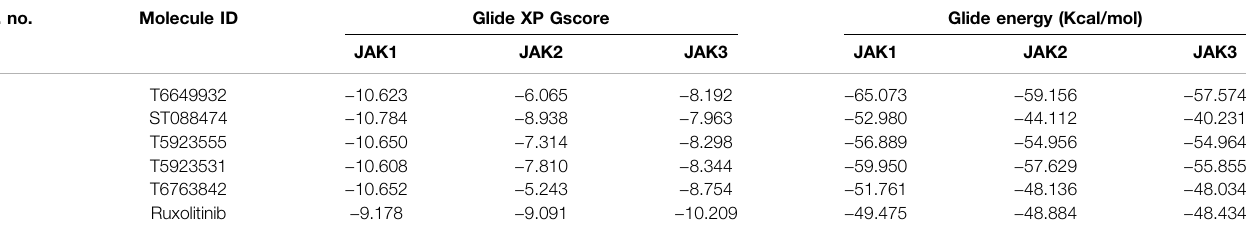
TABLE 10 | Cross-docking results of the selected JAK1 lead compounds and the drug. S.